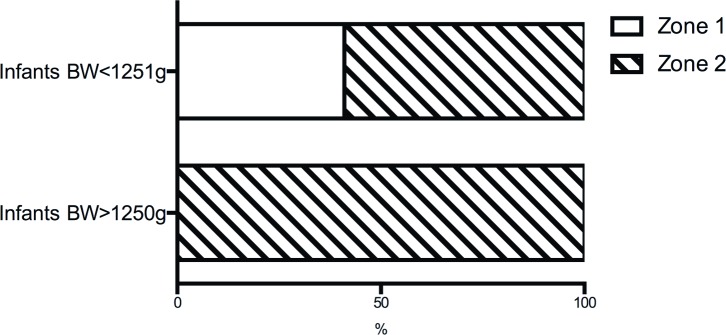
Comparison of Type 1 ROP location between large and small preterm infants.Type 1 ROP was in zone II retina of all eyes in the study, while 41% of them were in zone I retina of the small preterm infants. BW: birth weight. Data source of infants BW < 1251 g: the ET-ROP study [10].